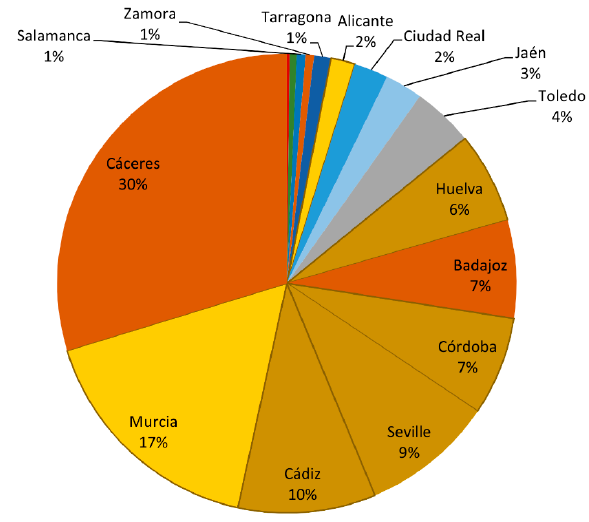
Figure 6. Provincial distribution (%) of cases recorded as positive for autochthonous malaria by Spanish antimalarial dispensaries in 1932. Provinces of the regions of Extremadura (Cáceres and Badajoz) are shown in the same colour, as are those of Western Andalusia (Cádiz, Seville, Córdoba and Huelva).